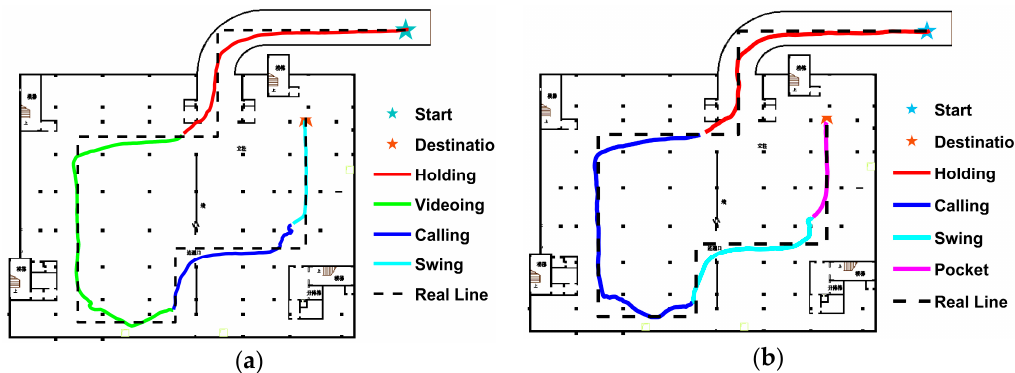
Figure 14. Tests in an underground parking garage with casual changes in the smartphone carrying mode: ( a ) holding-> videoing-> calling-> swing; ( b ) holding-> calling-> swing-> pocket.